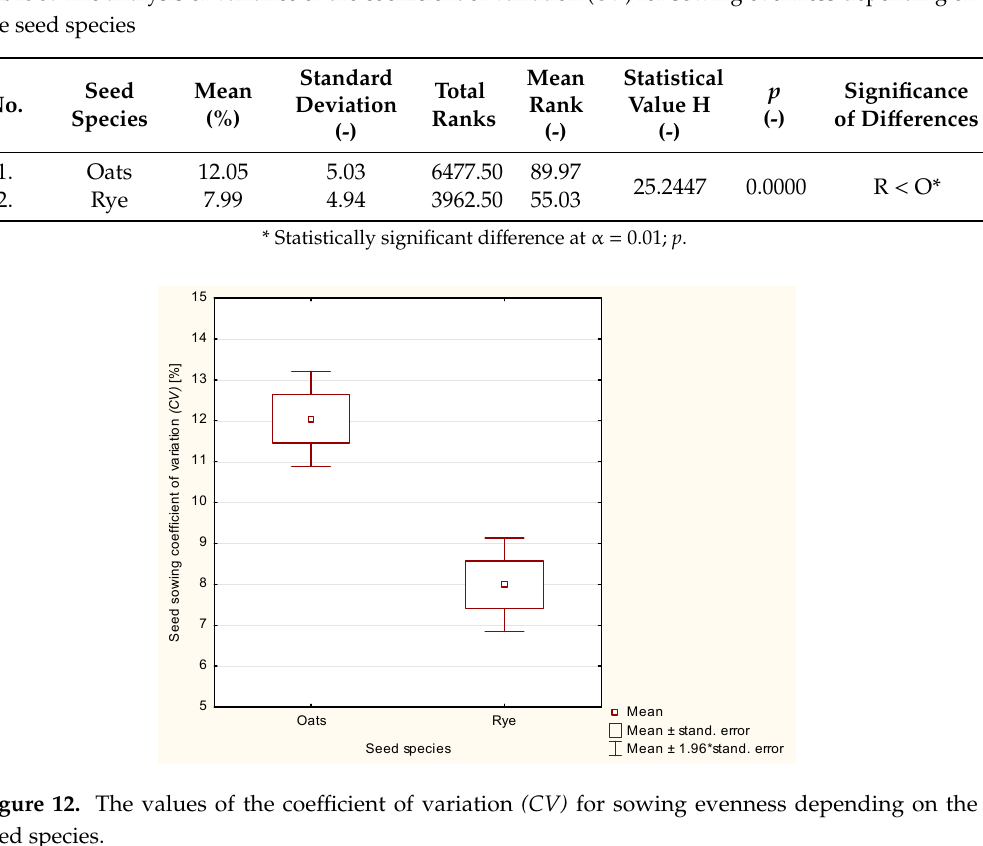
Table 3. The analysis of variance of the coe ffi cient of variation ( CV ) for sowing evenness depending on